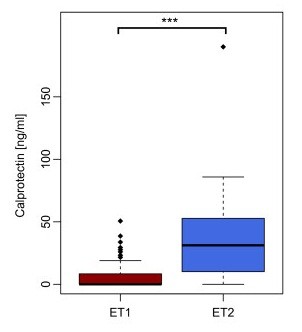
Calprotectin concentration (ng/ml) in enterotype 1 (ET1) and enterotype 2 (ET2). An elevated concentration of calprotectin was found in Bacteroidetes dominant enterotype (ET2) (P = 4.9 × 10-5, Wilcox rank sum test).